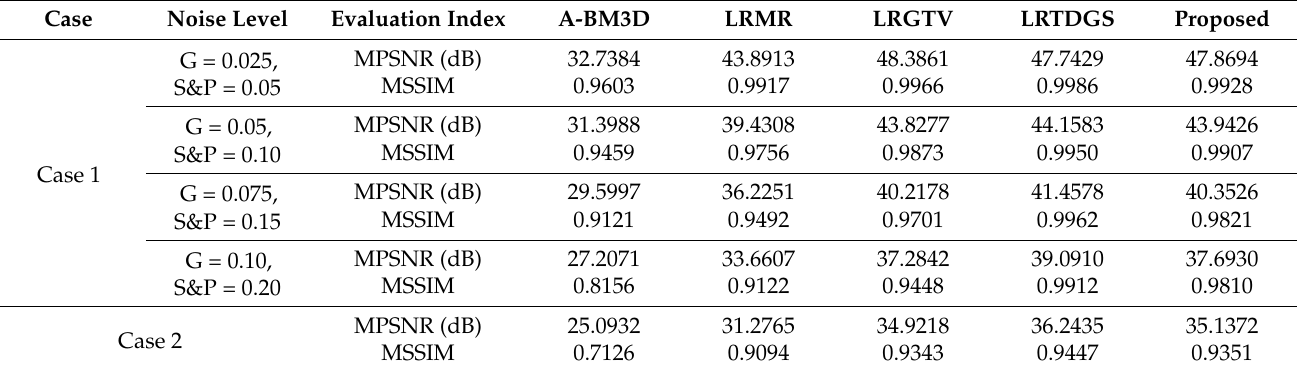
Table 2. Quantitative evaluation of the different methods on the Simu–Indian dataset.